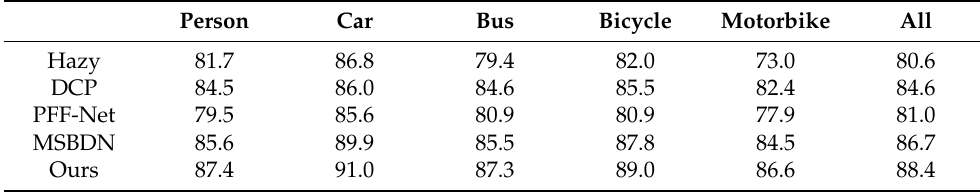
Table 2. Detection results on recovered